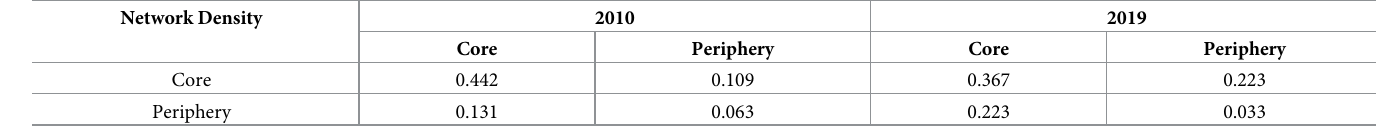
Table 4. The core-periphery density matrix of China’s provincial tourism eco-efficiency in 2010 and 2019. Network Density